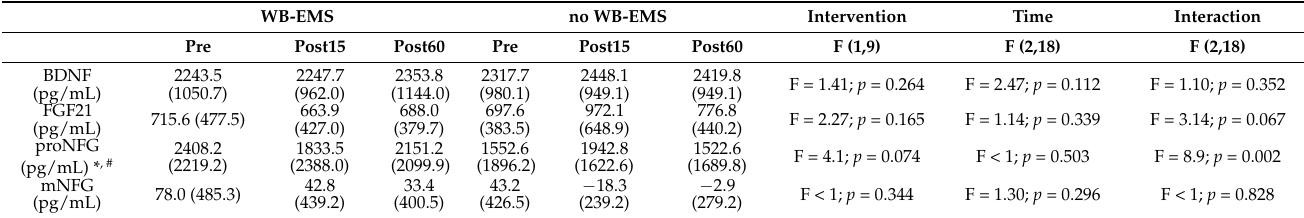
Table 3. Neurotrophic factor variables. Data as mean and